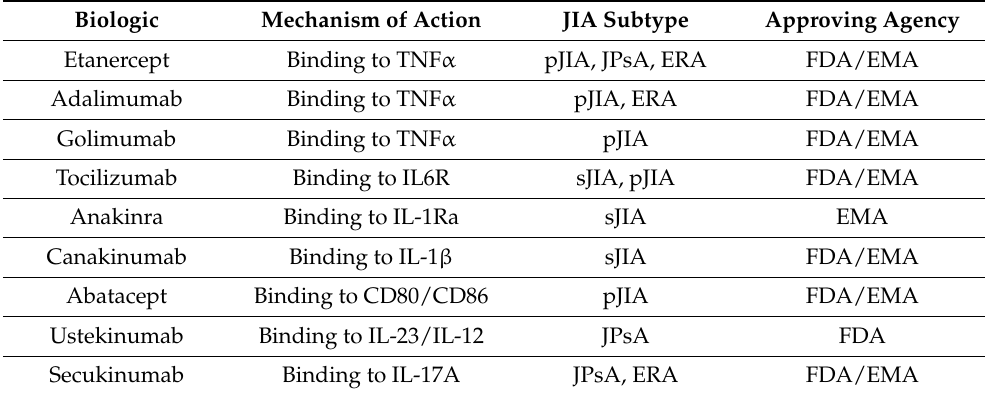
Table 2. Biologics currently approved for JIA